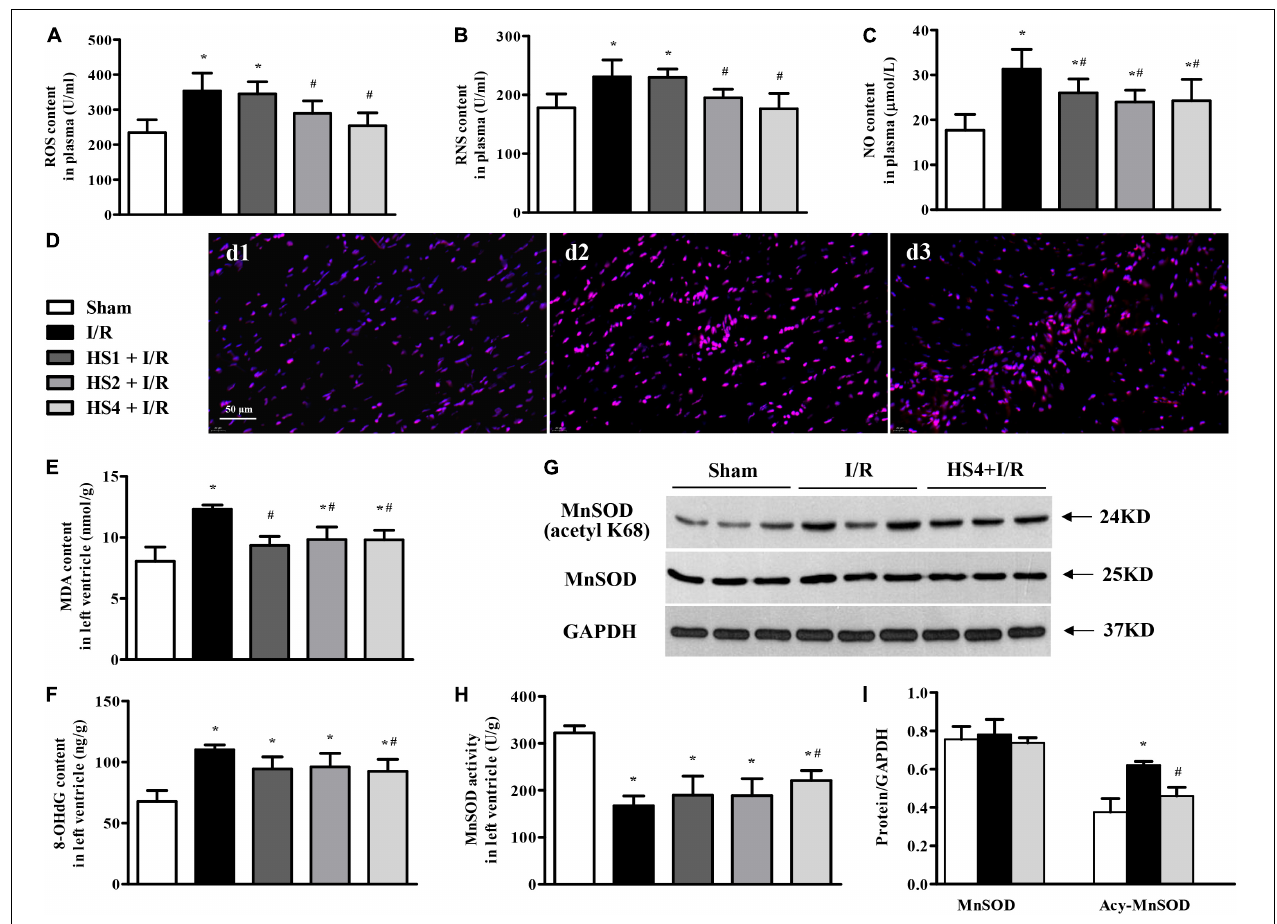
FIGURE 8 | Effect of Herba Siegesbeckiae (HS) on Ischemia/Reperfusion (I/R)-elicited oxidative stress. (A–C) The plasma contents of ROS (A) , RNS (B) , and NO (C) in different groups ( n = 9). (D) Representative ROS immunofluorescence photographs stained by DHE in Sham (d1), I/R (d2), and HS4 + I/R (d3) groups. Bar = 50 µ m. (E,F) The contents of MDA (E) and 8-OHdG (F) in the left ventricle in various groups ( n = 6). (G,H) The representative protein expression and quantitative analysis of MnSOD and Acy-MnSOD in left ventricle ( n = 3). (I) The activity of MnSOD in the left ventricle in different groups ( n = 6). * P < 0.05 vs. Sham group, # P < 0.05 vs. I/R